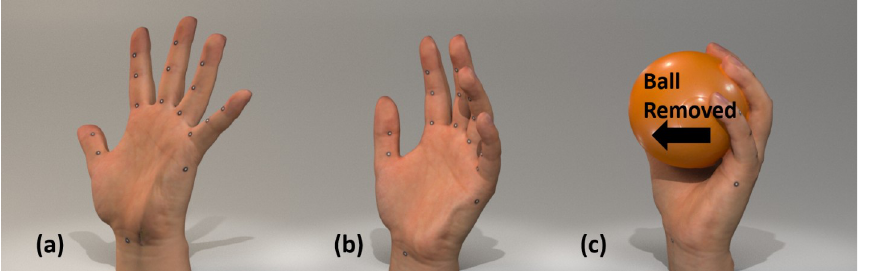
Fig 4. Hand postures. (a) hand with splayed fingers, (b) hand in relaxed state, and (c) ball grip